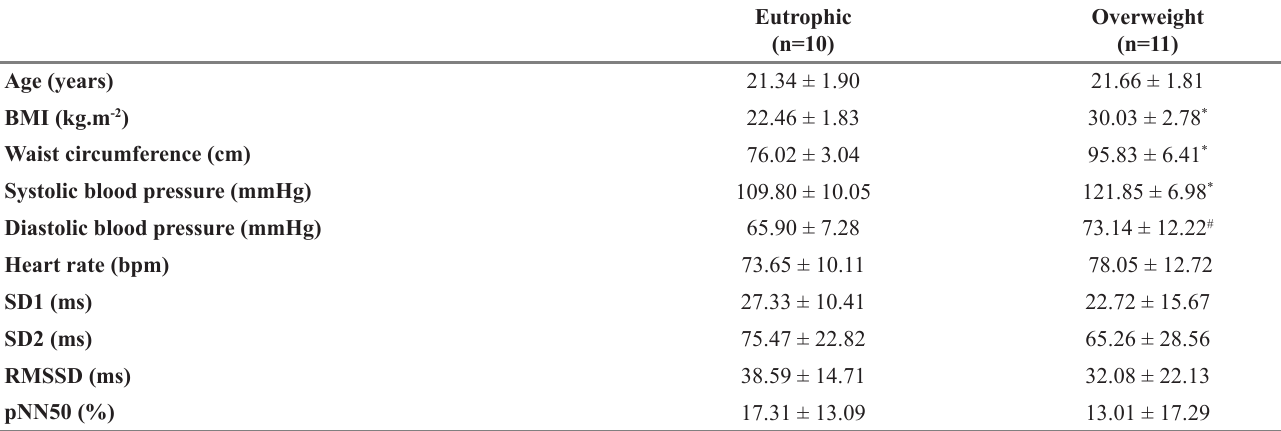
Table 1. Anthropometric variables, blood pressure and heart rate variability indexes at